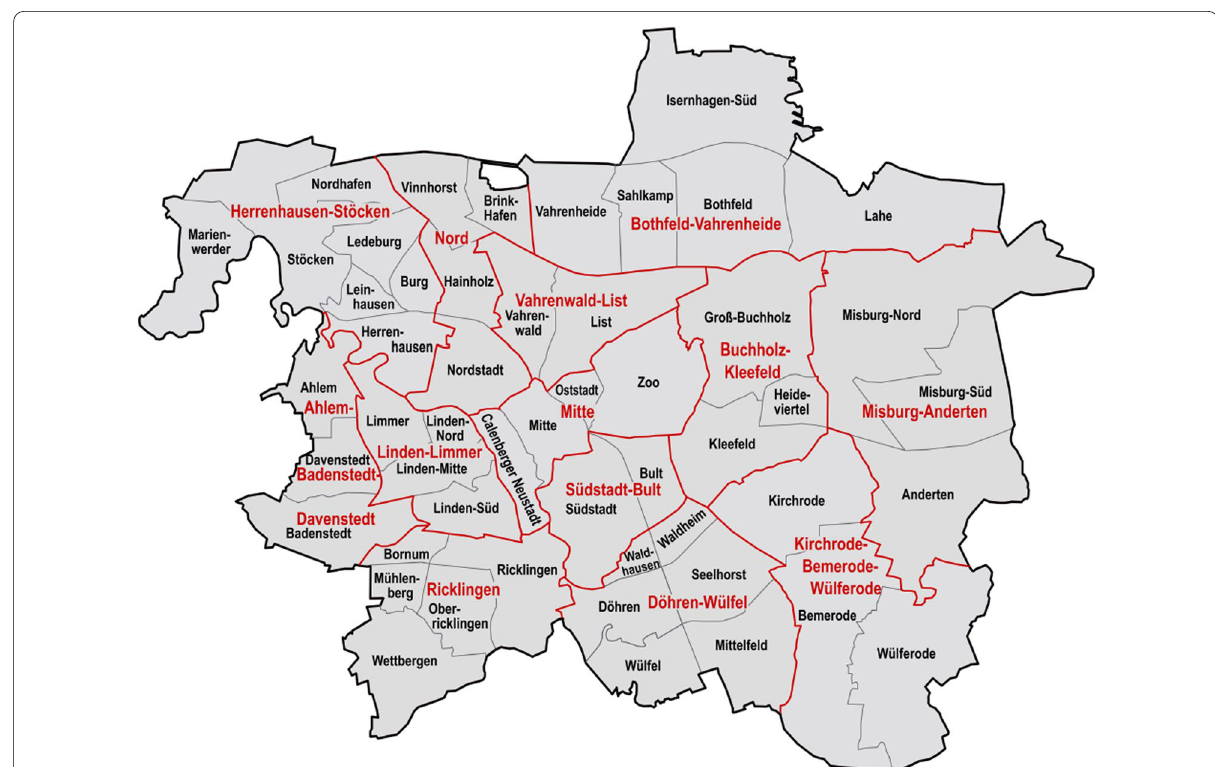
Fig. 2 Administrative division in the city of Hannover. There are 13 main districts in the city (source: official website of the city www. hanno ver.